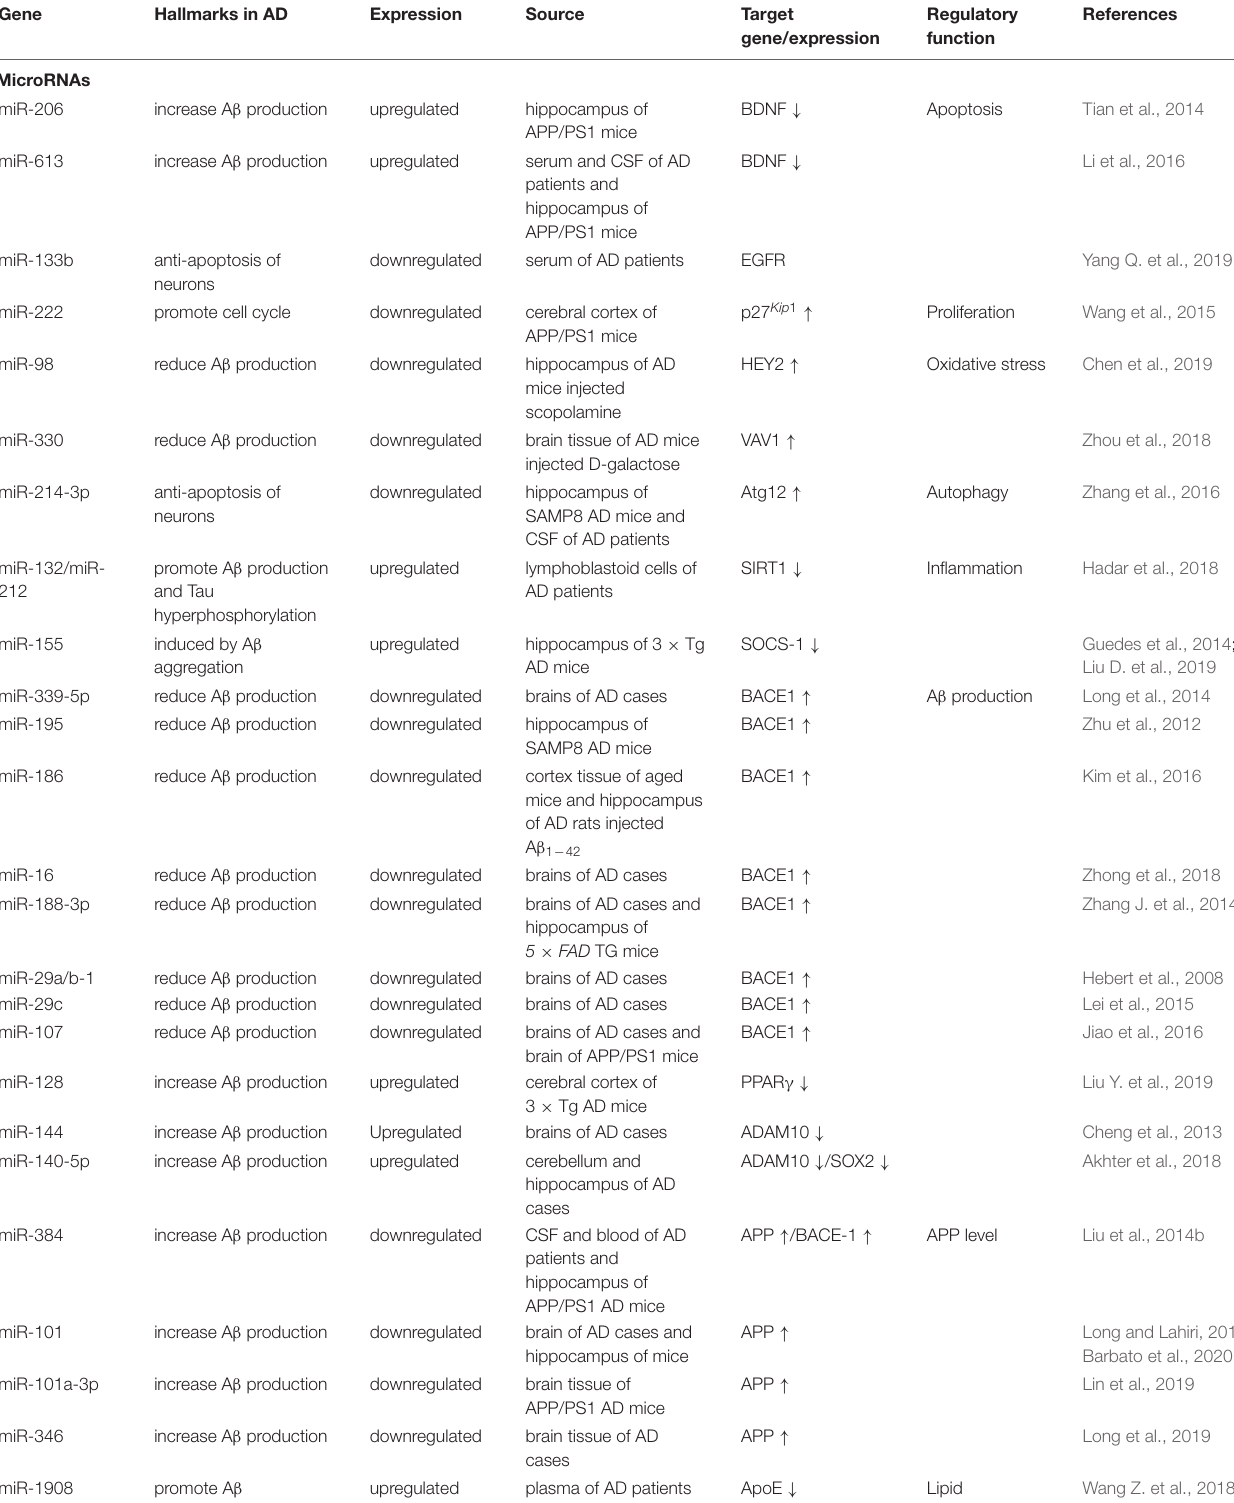
TABLE 1 | Summary of ncRNAs as potential therapeutic targets for